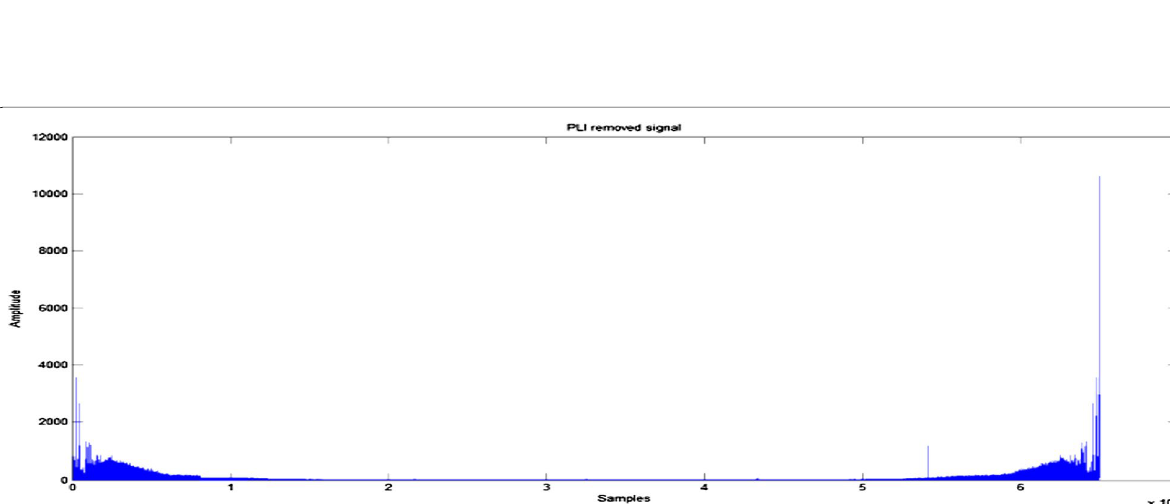
Fig. 10 PLI removed signal of record number 100: The figure represents power line interference removed signal in frequency domain at 60 Hz